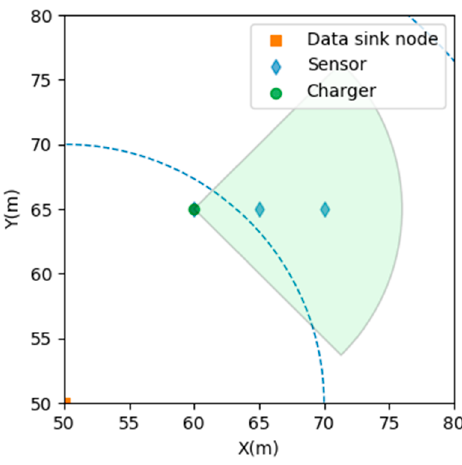
Figure 4. Covers all sensors with one charger.